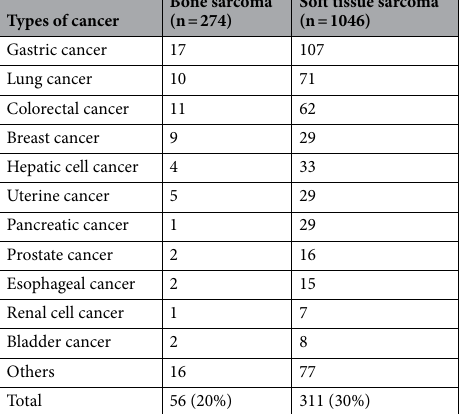
Table 3. Types of cancer in first-degree relatives of sarcoma